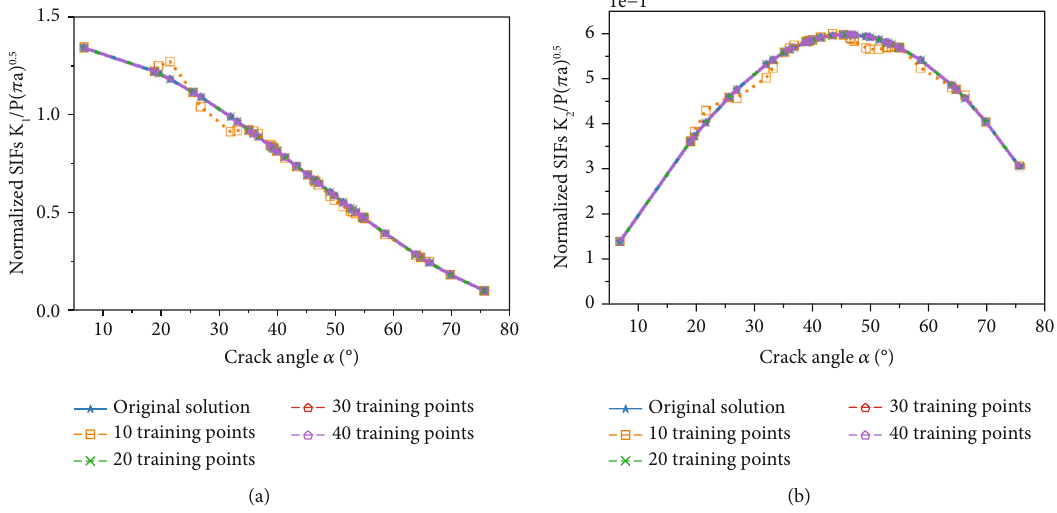
/ P ð π a Þ 0 : 5 1 / P ð π a Þ 0 : 5 varies with the crack angle under 2